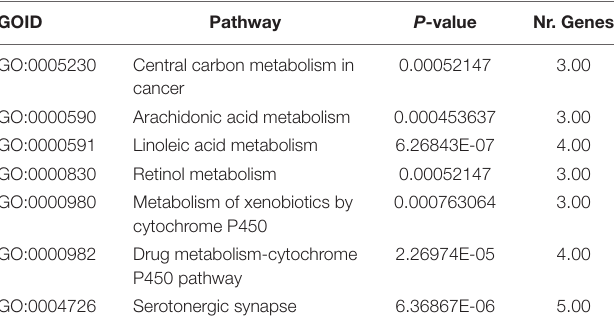
TABLE 3 | Enriched KEGG pathways of the top 20